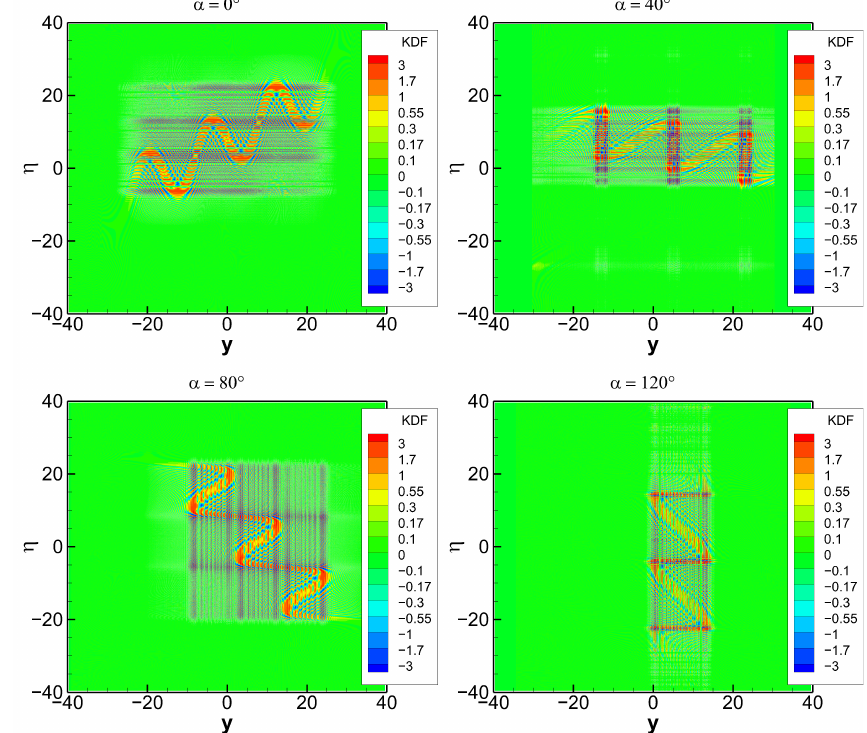
Figure 6. KDF ρ K α of function ˜ ψ α ( y ) in rotated coordinates ( y , η ) . The rotation angle α takes the values of 0 ◦ , 40 ◦ , 80 ◦ , and 120 ◦